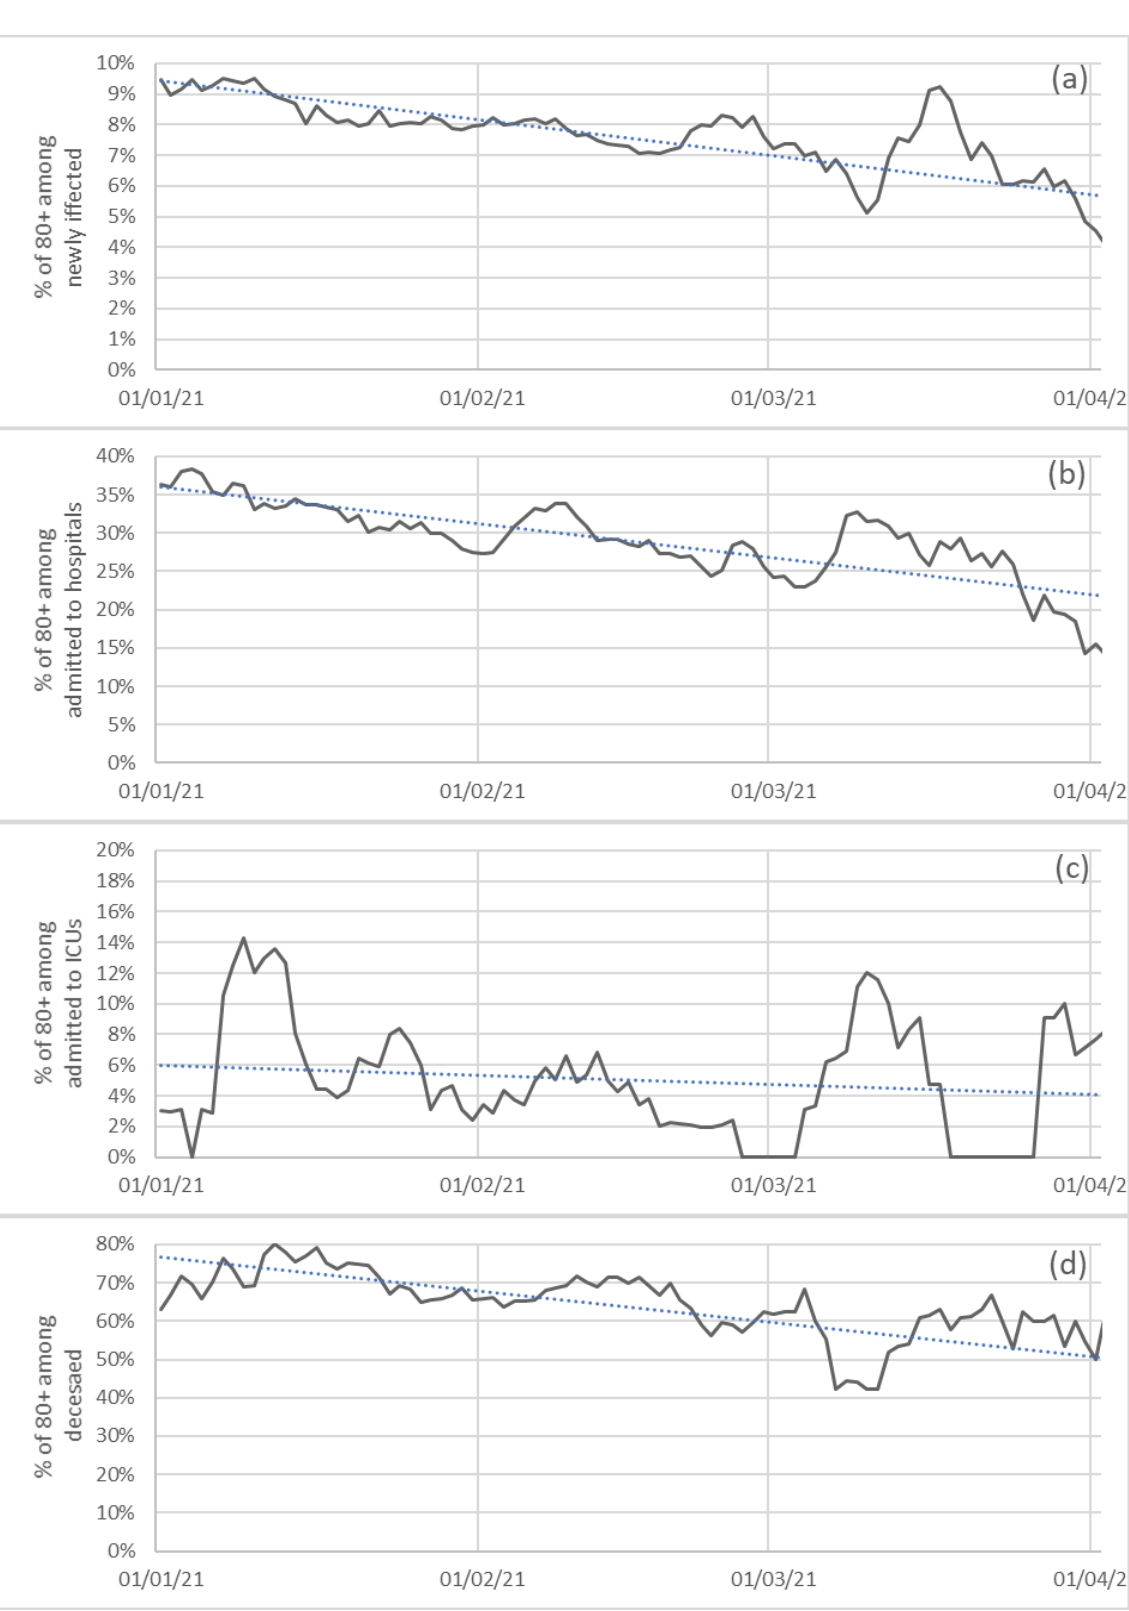
Figure 5. Percentages of 80+ among newly infected ( a ), admissions to hospitals ( b ), admissions to intensive care units ( c ) and deceased ( d ) in Galicia since 1st January 2021 for the age group 80+.